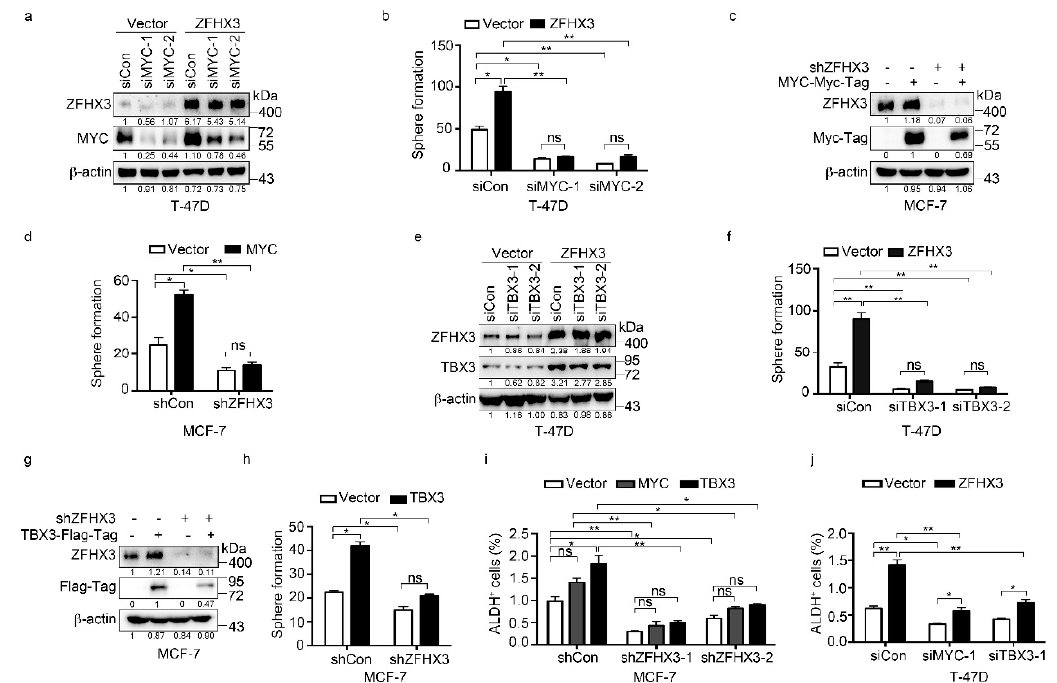
Figure 5. MYC and TBX3 play a role in ZFHX3-mediated sphere formation in Matrigel and ALDH + cell population in ER + MCF-7 and T-47D breast cancer cells. ( a , b ) In T-47D cells ectopically expressing ZFHX3, MYC silencing, as confirmed by western blotting in 2D culture ( a ), and culture in Matrigel (3D culture) that attenuated sphere formation in both ZFHX3 and vector control groups ( b ). ( c , d ) In MCF-7 cells with ZFHX3 silencing, MYC ectopic expression, as confirmed by western blotting in 2D culture ( c ), and culture in Matrigel (3D culture) that did not significantly increase sphere number ( d ). ( e , f ) In T-47D cells ectopically expressing ZFHX3, TBX3 silencing, as confirmed by western blotting in 2D culture ( e ), and culture in Matrigel (3D culture) that attenuated sphere formation ( f ). ( g , h ) In MCF-7 cells with ZFHX3 silencing, TBX3 ectopic expression, as confirmed by western blotting in 2D culture ( g ), and culture in Matrigel (3D culture) that did not significantly increase sphere number ( h ). ( i , j ) ALDH + cells were then detected by flow cytometry in MCF-7 cells with ZFHX3 silencing and MYC or TBX3 overexpression ( i ) and T-47D cells with ZFHX3 overexpression and MYC or TBX3 knockdown ( j ). ns, not significant; * p < 0.05; ** p < 0.01. Cells were cultured on a 2D plastic surface. siCon, control siRNA; siZFHX3, siRNA against ZFHX3 . Ratios of protein band intensities to those of their loading controls, with the control sample’s normalized to 1, are shown under western blot bands ( a , c , e , g ). Uncropped western blot images are available in Supplementary Figure S9.